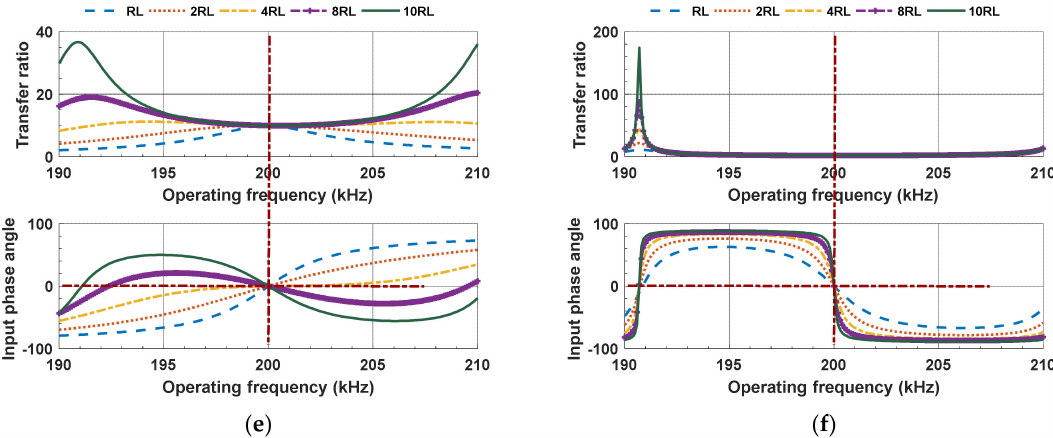
Figure 31. Voltage transfer ratio and phase angle of the input impedance simulation results for: ( a ) CLC/S; ( b ) LC/P; ( c ) CL; ( d ) CL/P; ( e ) S/LC; and ( f ) S/LCC topologies versus operating frequency.